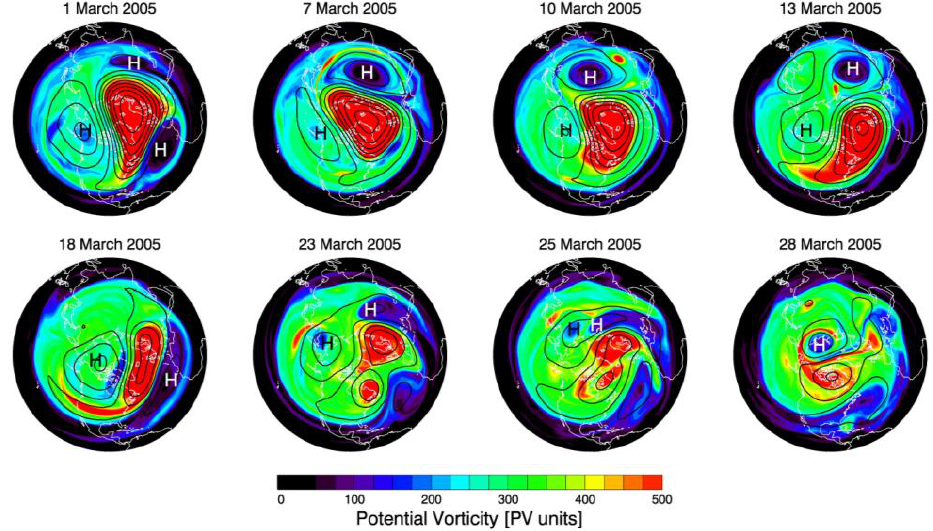
Fig. 2. Northern Hemisphere Ertel potential vorticity at 850K potential temperature for 1, 7, 10, 13, 18, 23, 25, and 28 March 2005. PV units are used, where 1 PVU = 1.0 × 10 − 6 m 2 s − 1 Kkg − 1 . Red (blue) indicates high (low) values of PV. Black lines indicate 10hPa geopotential height at 250-m contour intervals. The black “H” marks the location of the Aleutian anticyclone and the white “H”s mark the locations of other anticyclones.